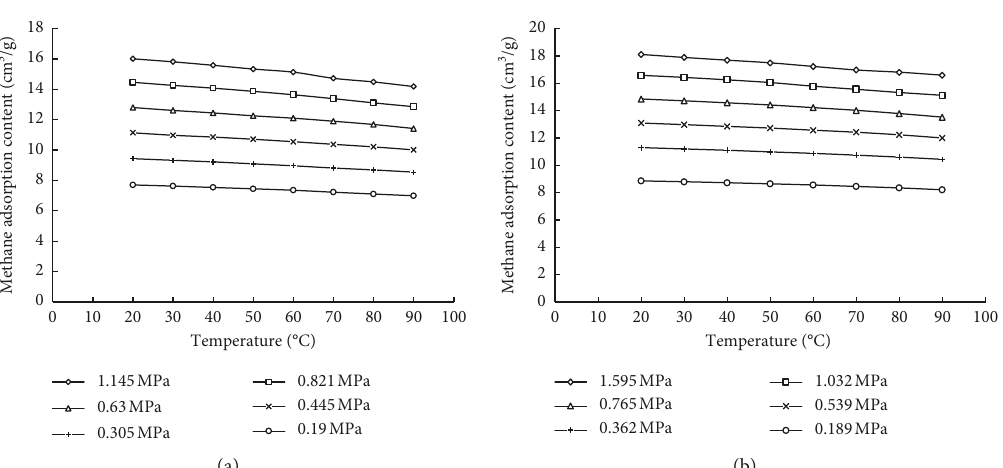
Figure 4: Methane adsorption content with different initial free gas content at different temperatures. (a) #1 coal sample (b) #2 coal sample.